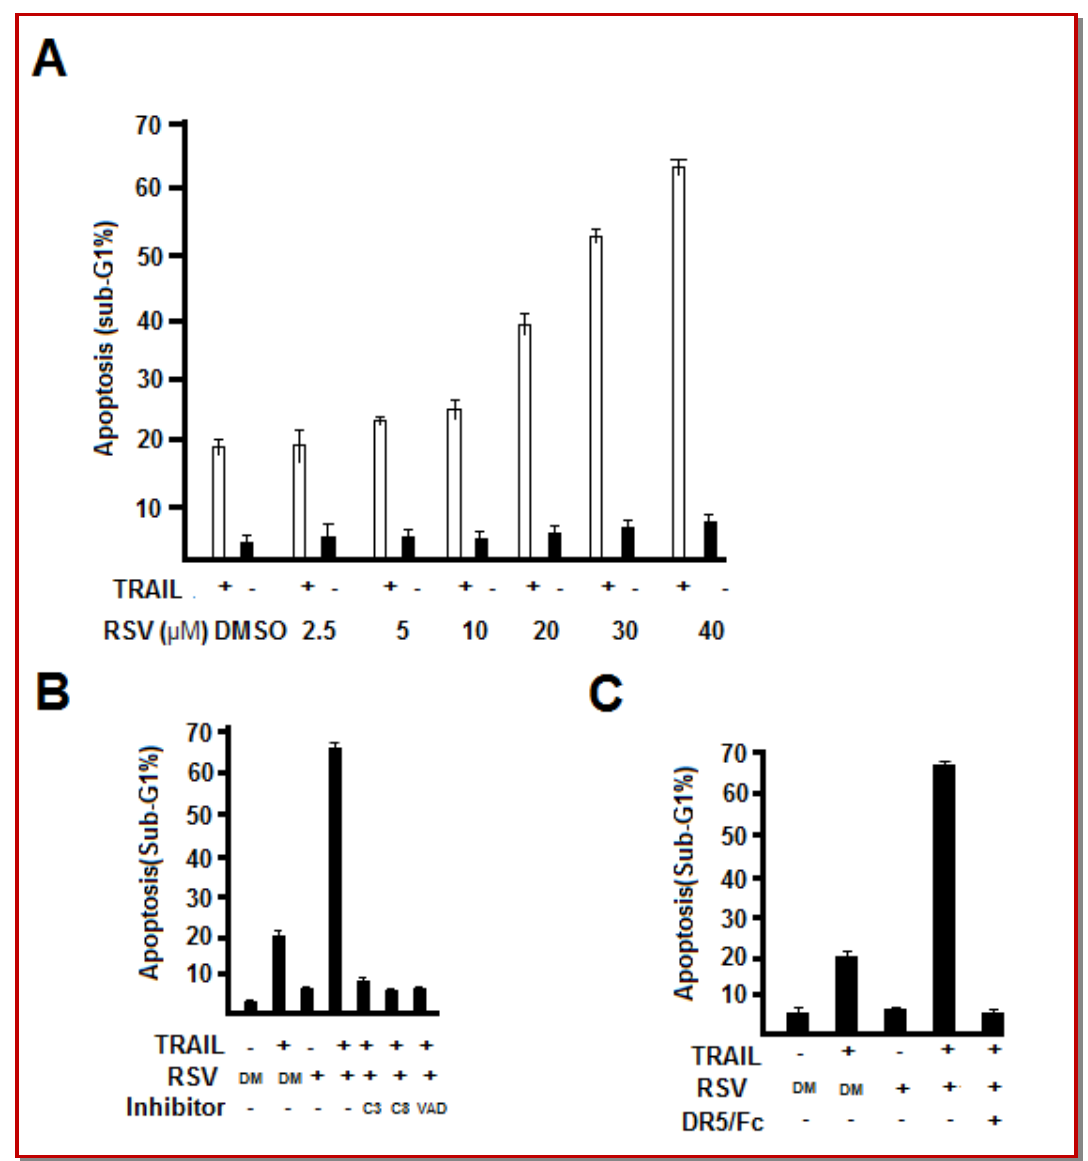
Figure 2: Resveratrol sensitizes Caco cells to TRAIL-induced apoptosis. (A) Caco cells with 50 ng/mL TRAIL and the indicated concentrations of resveratrol for 24 hours. (B) Caco cells were cultured in the presence or absence of 20 ng/mL TRAIL and/or 40 µM resveratrol with or without 20 µM of the caspase inhibitors. (C) Cells were treated as shown in (B) with or without 1 µg/mL of DR5/Fc protein. The values shown are means (n = 3); bars, ±